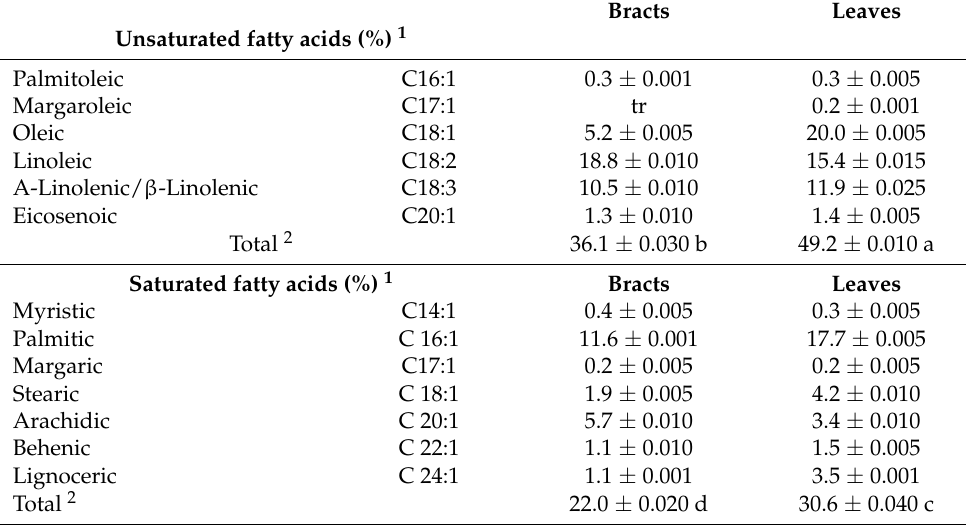
Table 6. Composition in fatty acids for the discarded bracts and senescent leaves of the artichoke Bianco of